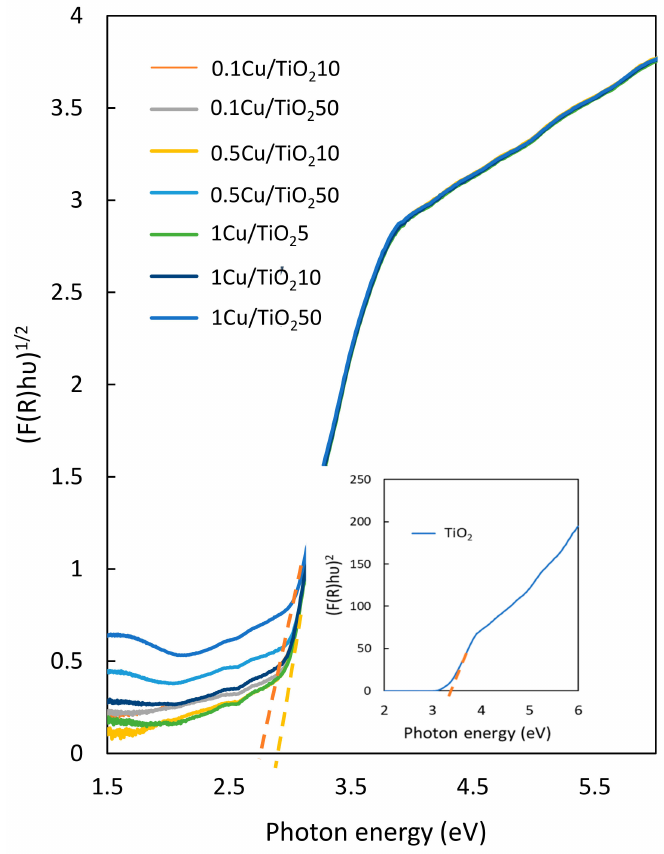
Figure 4. UV–Vis di ff use reflectance spectra of pristine TiO 2 and the nanocomposite